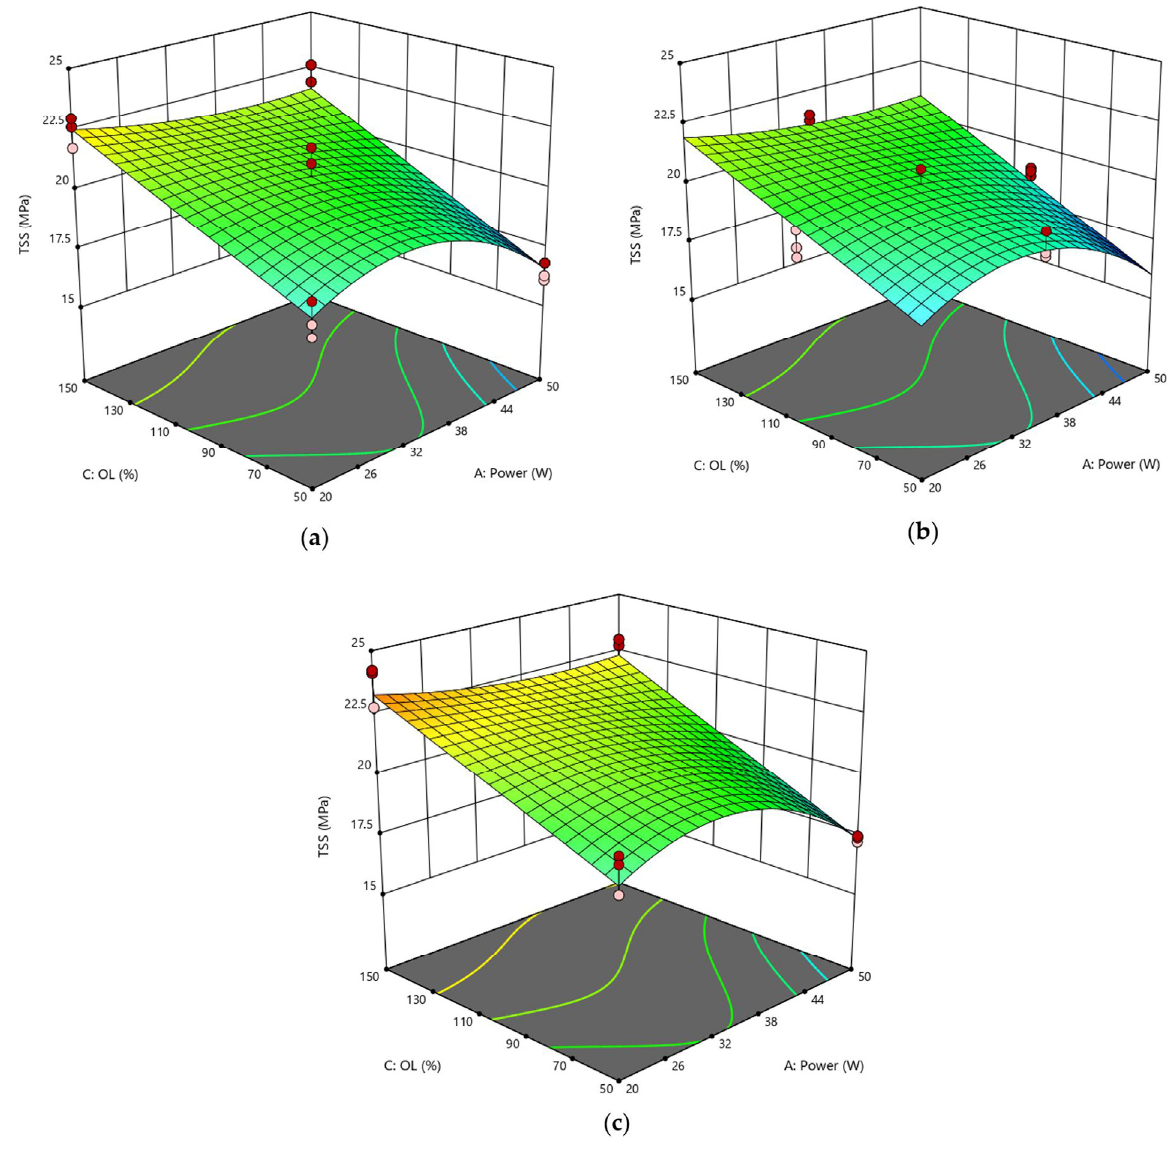
Figure 9. RSD 2: ( a ) h = 50%; ( b ) h = 100%; ( c ) h = 150%.